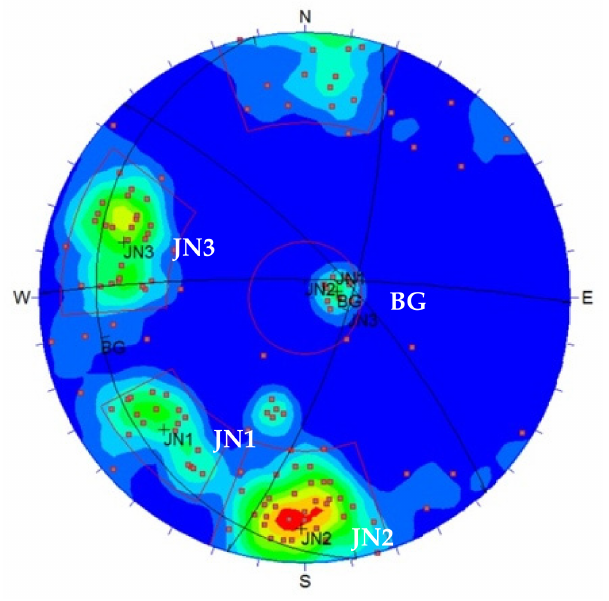
Figure 12. Stereographic projections of the poles and discontinuity planes’ concentration.